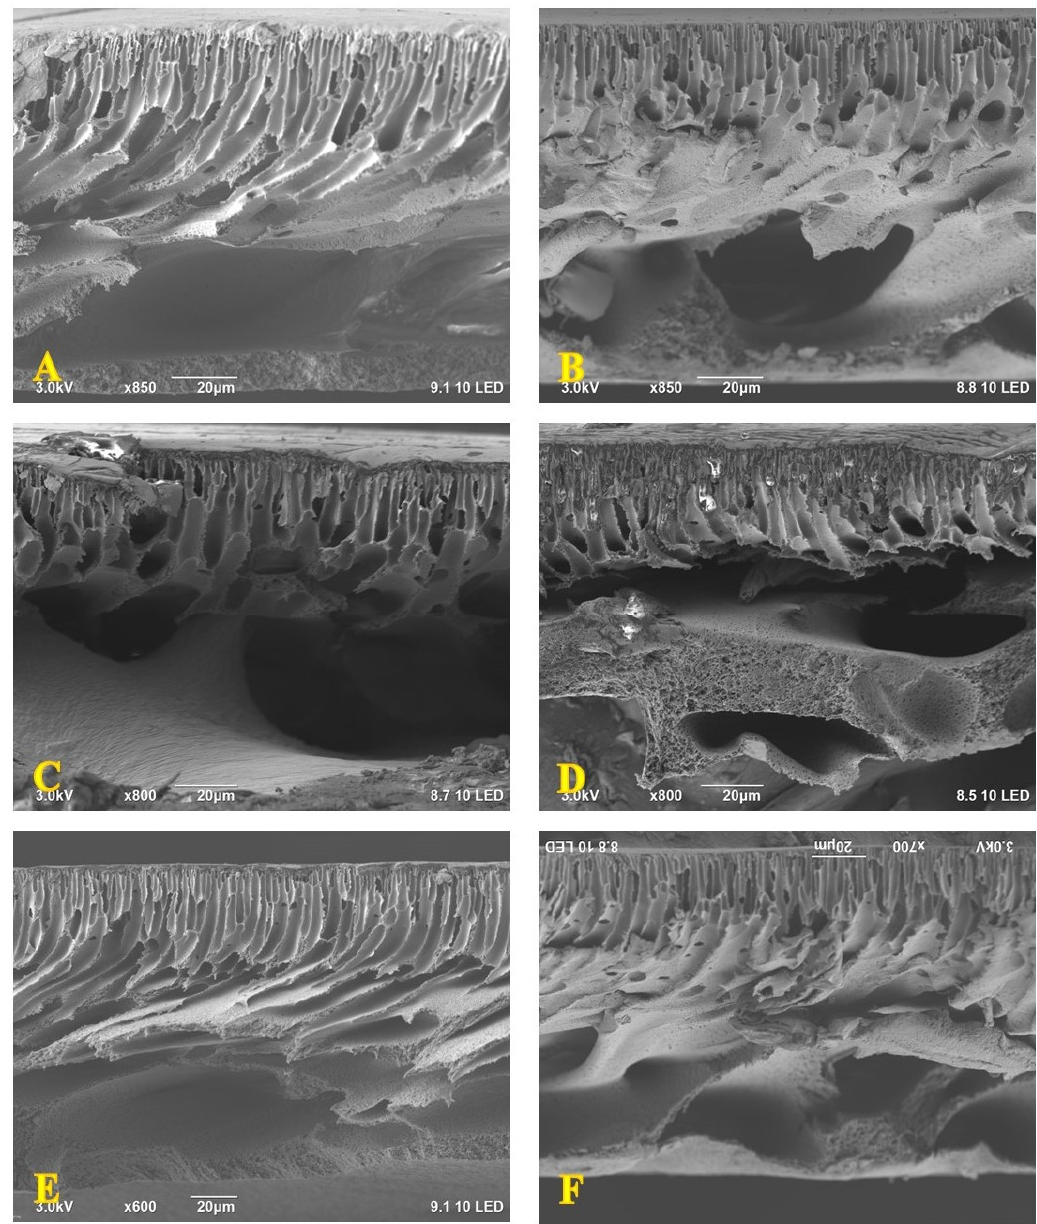
Figure 2. Cross-sectional morphology of ( A ) control PPSU, ( B ) 0.1-M, ( C ) 0.3-M, ( D ) 0.6-M, ( E ) 1-M and ( F ) 1.5-M membrane.